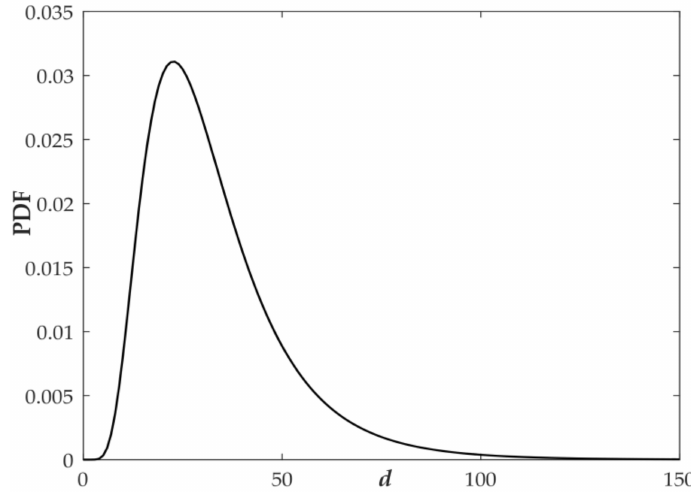
Figure 5. PDF of daily distance traveled of EV.